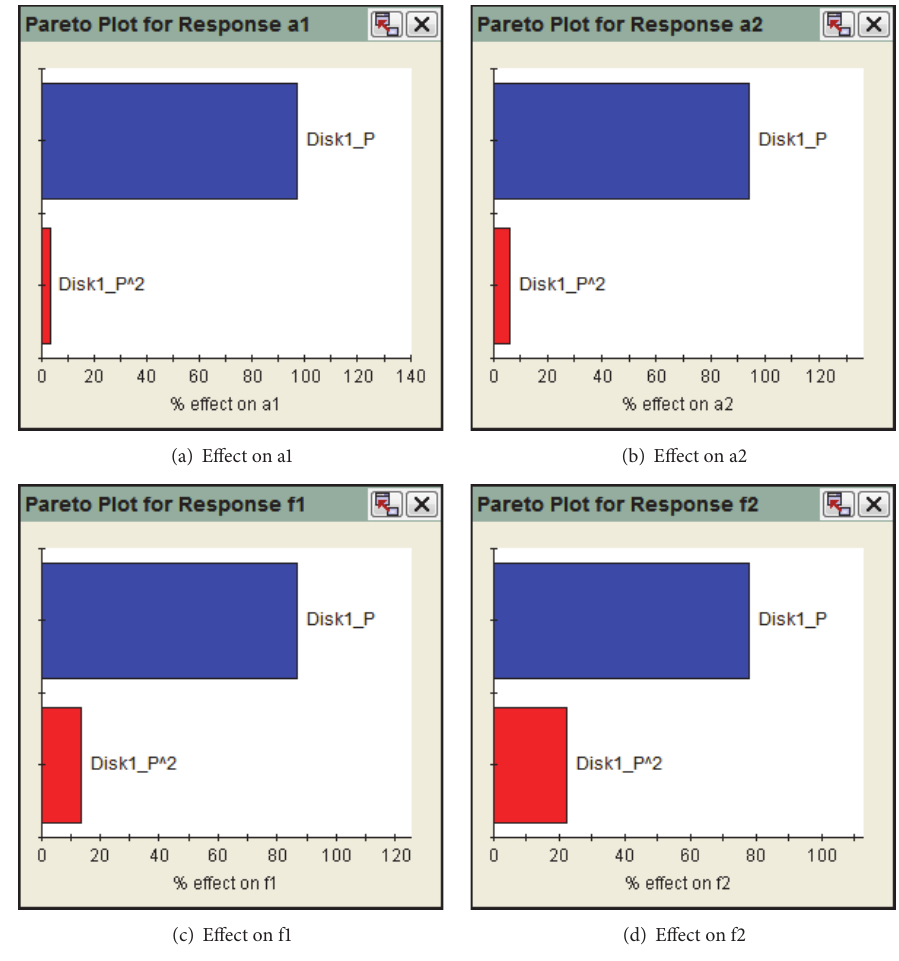
Figure 6: Effect of changing Disk1 P on optimization objectives.